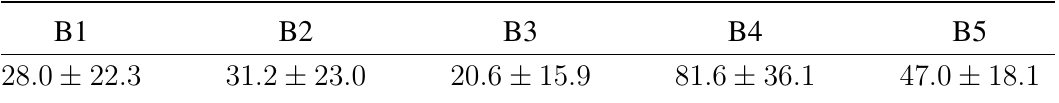
Table 1. Given a building, evaluation of the number of daily profiles ( ¯ x ± σ c ≥ 0 . 8 (Pearson’s correlation index) with a daily profile selected at